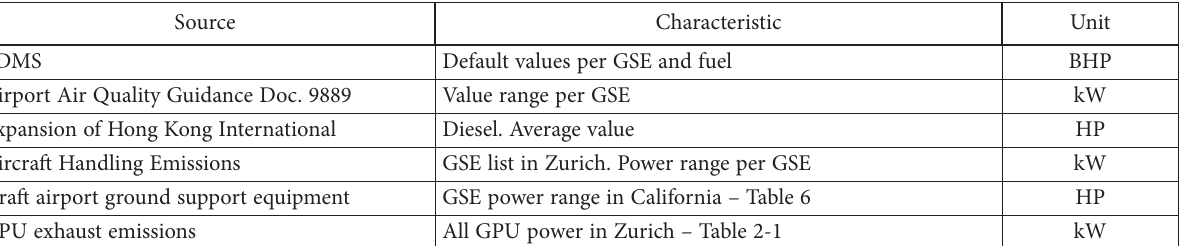
Table 4. Technical specifications and power plant according to the suggested bibliography (source: authors)